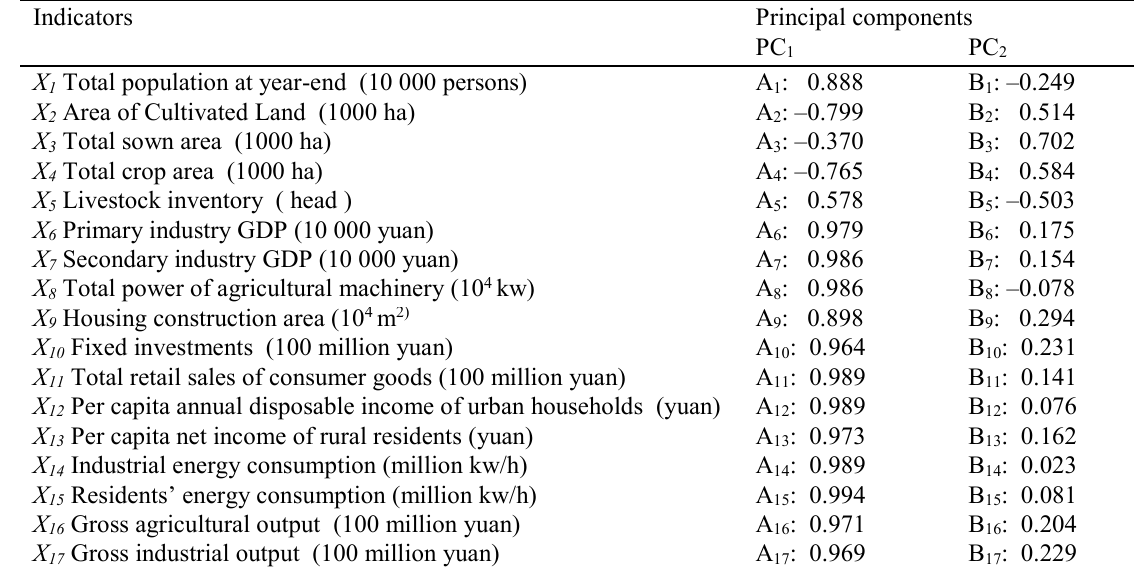
Table 2 Coefficients of the 17 socio-economic indicators in the first two principal